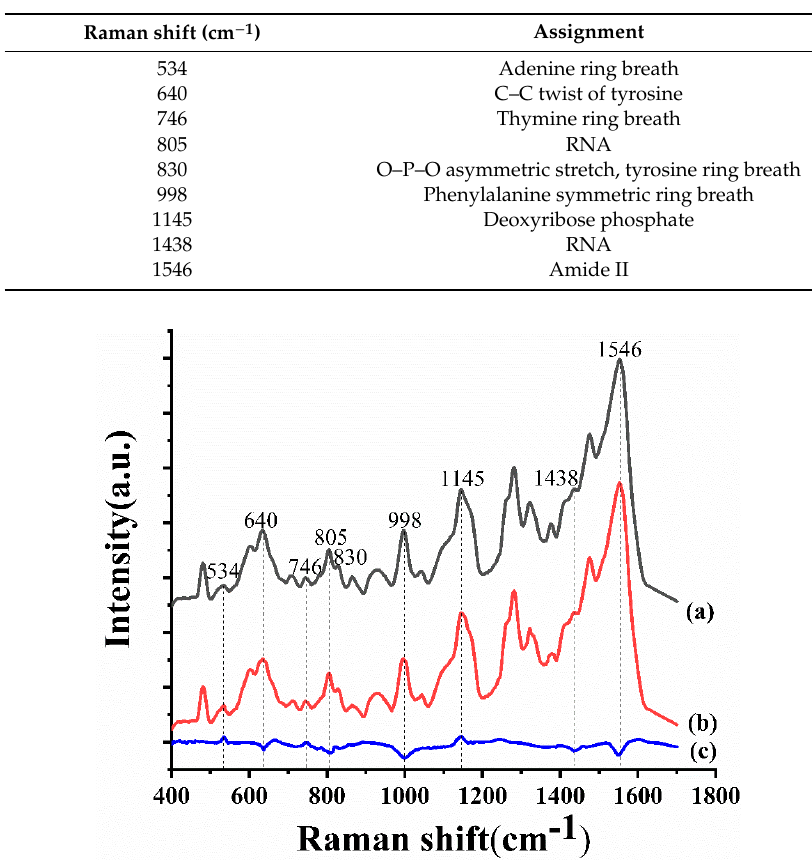
Table 1. Raman peak frequencies and their assignments.